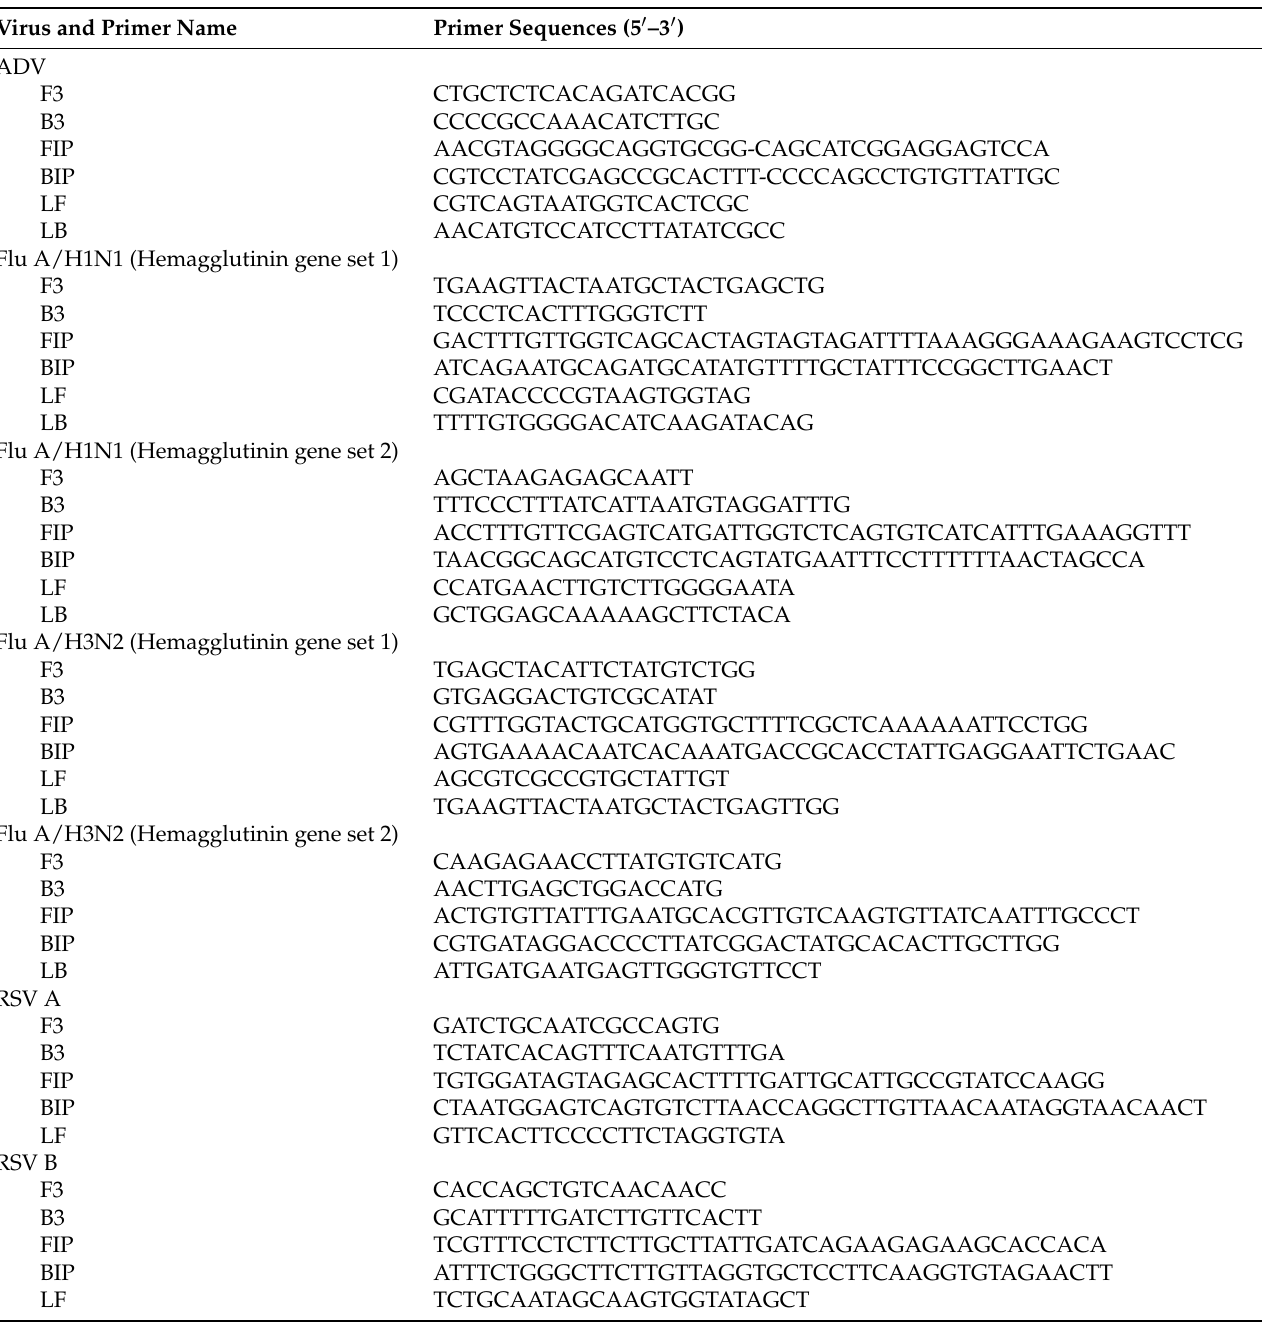
Table 1. RT-qLAMP primer sets used in this